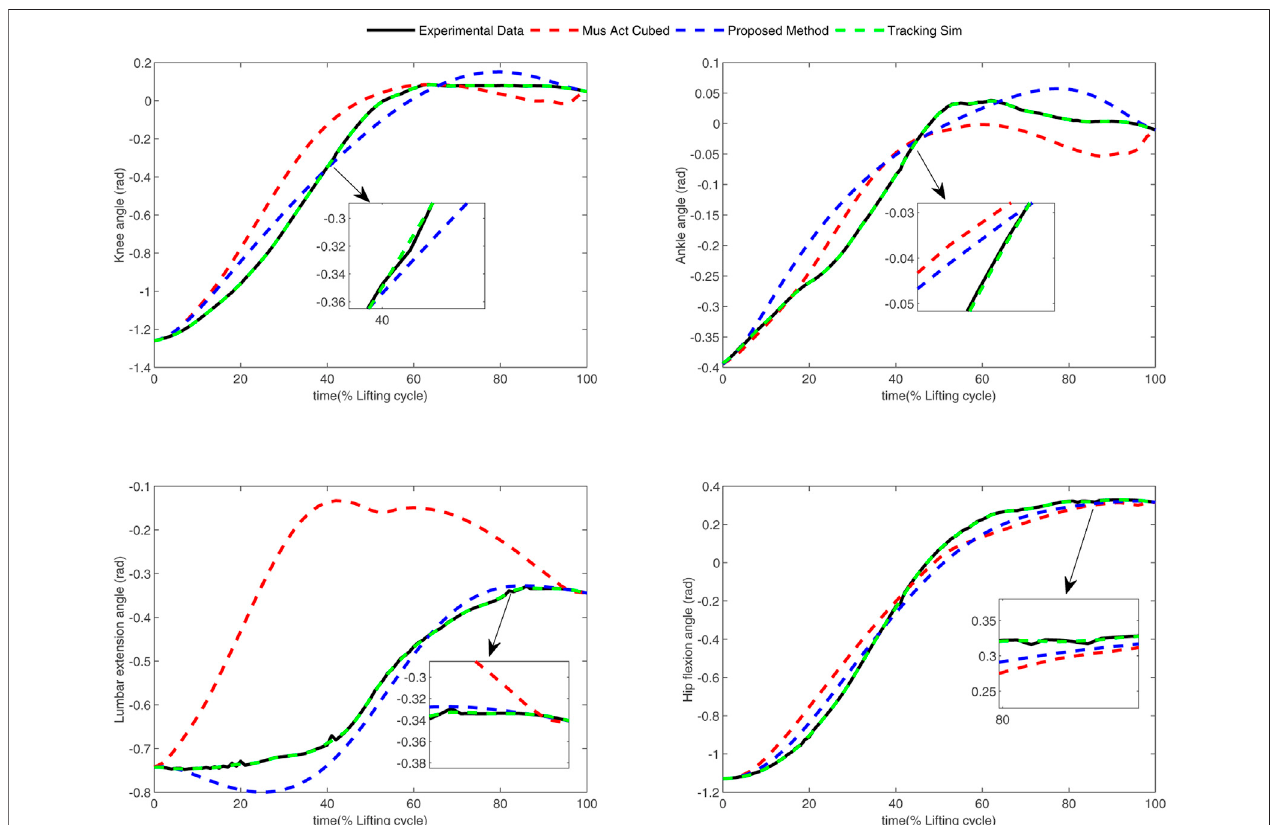
FIGURE 7 | Kinematics results of different joints obtained by different methods for subject